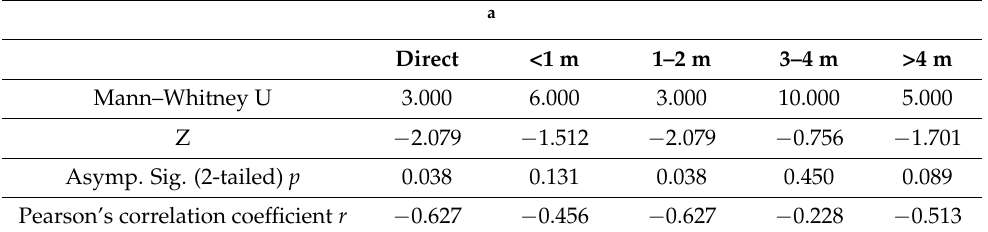
Table 6. Significances for distance to the fence between related and unrelated elephants during